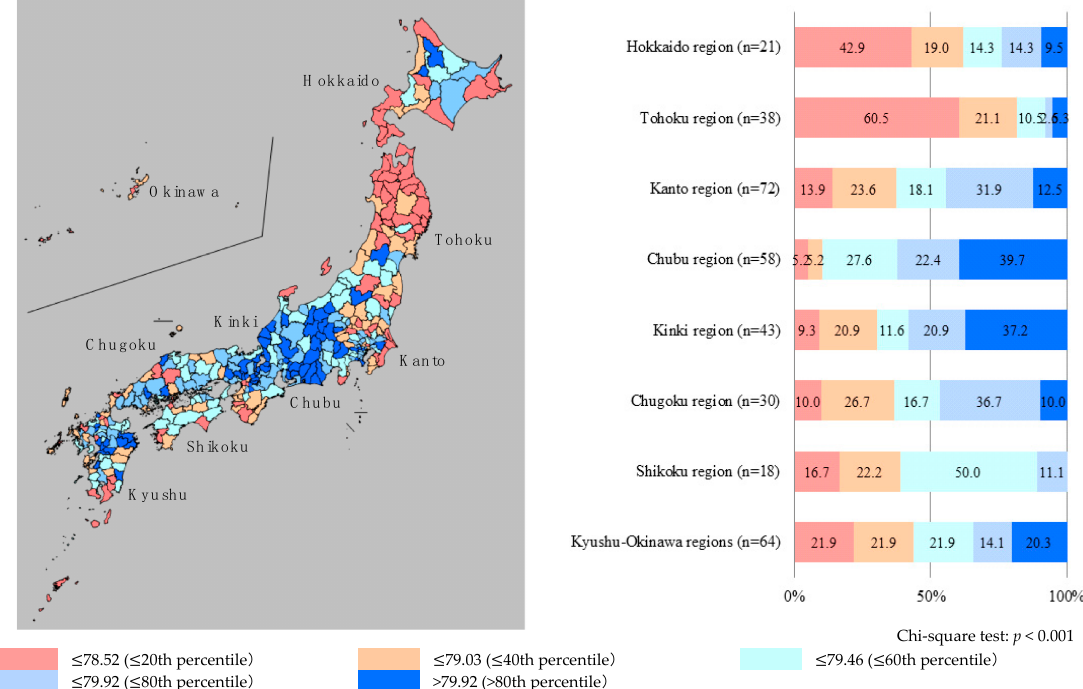
Figure 1. Distribution of healthy life expectancy for males in each secondary medical area. Note: Healthy life expectancy was divided into five categories, by 20th percentiles. The “n” means the number of secondary medical areas in eight regions (Hokkaido, Tohoku, Kanto, Chubu, Kinki, Chugoku, Shikoku, and Kyushu-Okinawa regions).